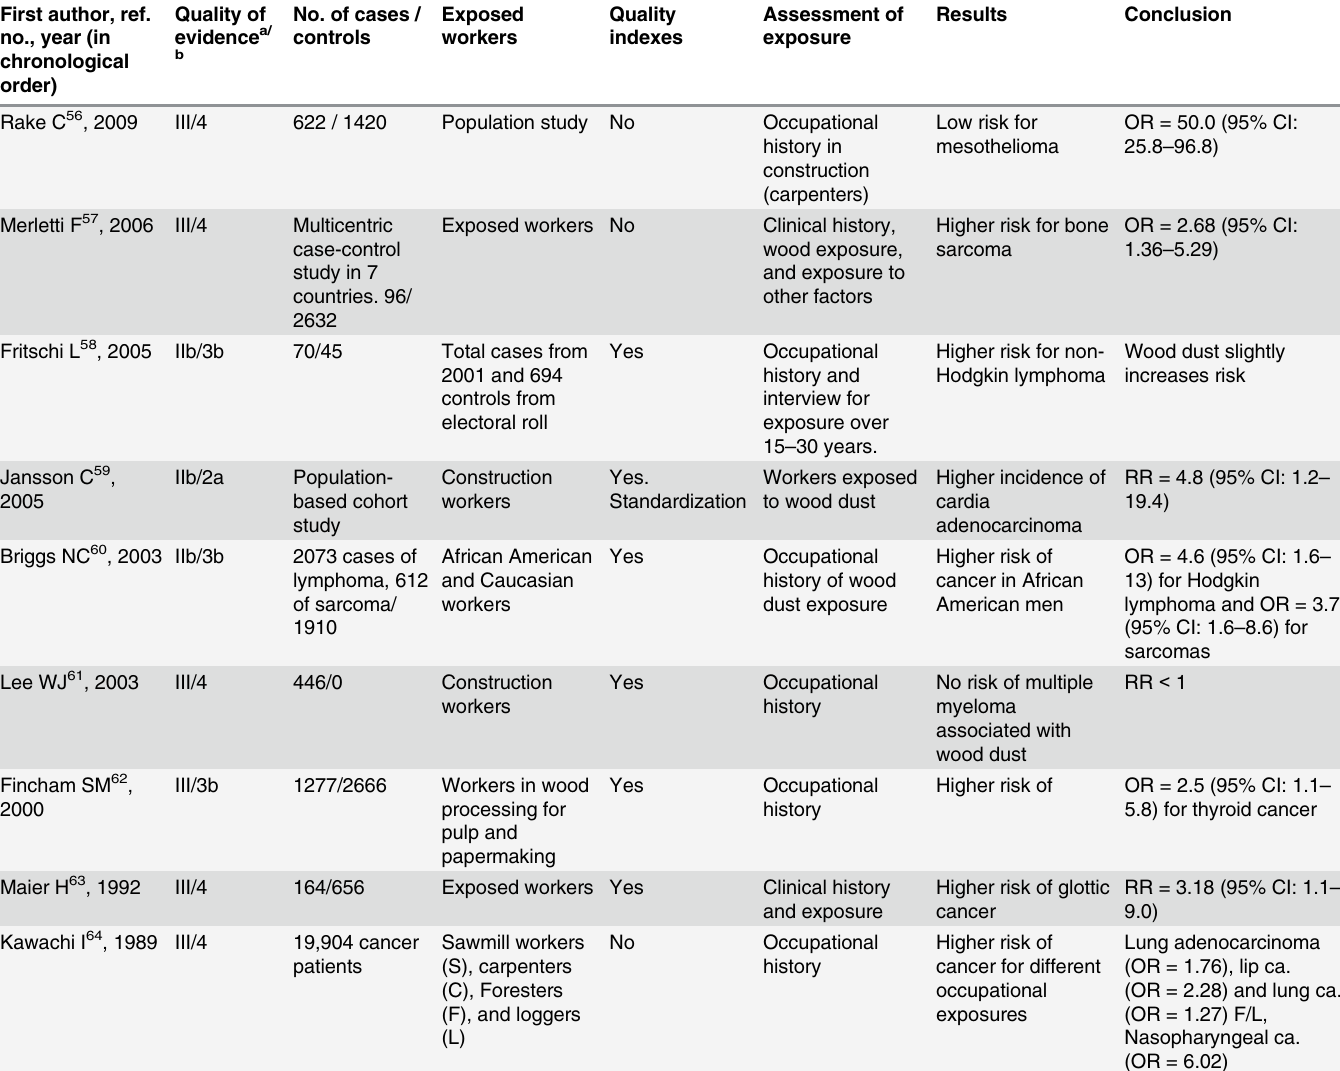
Table 3. Summary of published results on the relationship between exposure to wood dust and other types of cancer. First author, ref. no., year